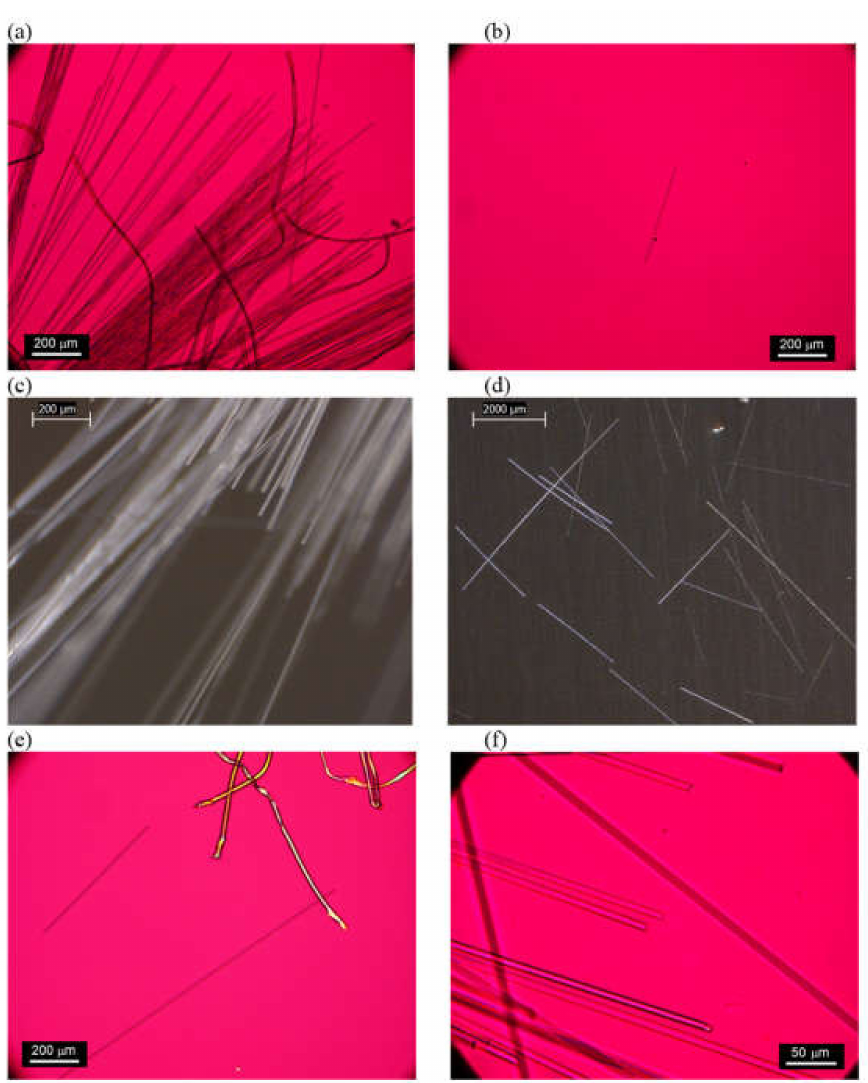
Figure 6. ( a ) Fiberglass (straight) in FG-3 inner sock material with synthetic fibers (wavy) (100 × PLM). ( b ) Rare fiberglass fragment in FG-3 bottom, outer cover material (100 × PLM). ( c ) Fiberglass in FG-4 inner sock (80 × stereozoom). ( d ) Fiberglass shed onto foil surface after FG-4 inspection (10 × stereozoom). ( e ) Fiberglass in FG-4 inner cover material with synthetic fibers (100 × PLM). ( f ) Higher magnification of fiberglass morphology from FG-4 inner sock (400 ×